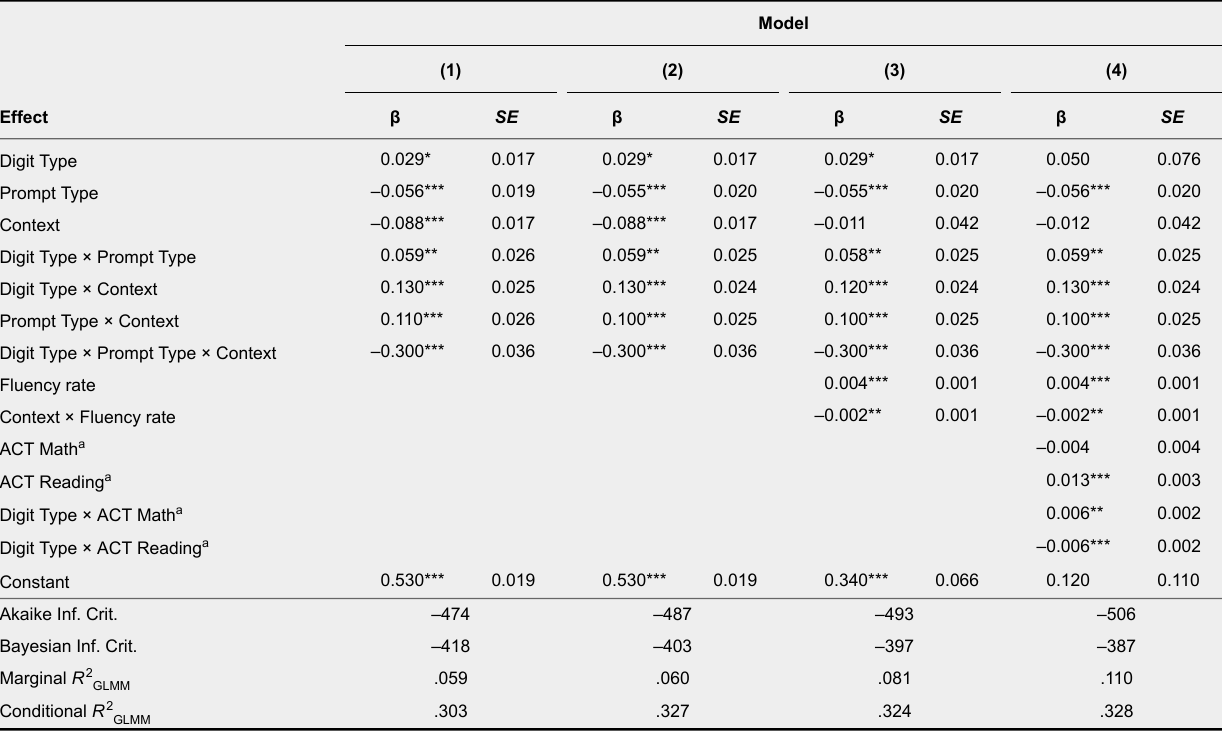
Linear Mixed Effects Regression Weights of Inverse RT (trials/s) on the Sentence Verification task (n = 73)